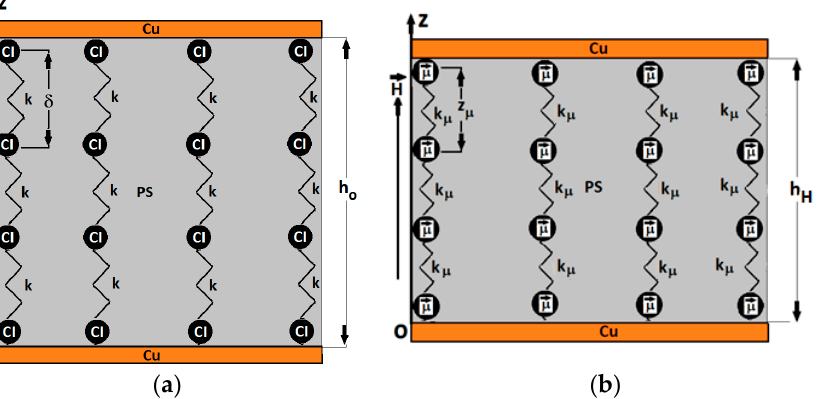
Figure A3. Cross section by MTS: ( a ) in the absence of the magnetic field and the deforming forces; ( b ) after the application of the magnetic field ( µ , magnetic moment vector; Cu, copper foil; PS, polyurethane sponge; k, k µ , elastic constants before and after the application of the magnetic field, respectively; H, magnetic field intensity vector; Oz, coordinate axis; δ , the initial distance between the mass centers of the CI microparticles; z µ , the distance between the magnetic dipoles at the moment t from the application of H).